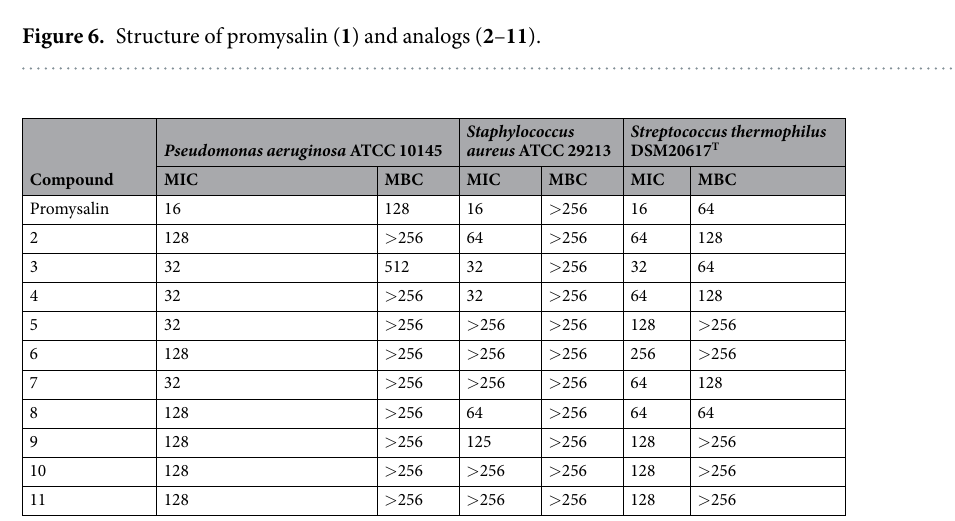
Table 2. Minimal inhibitory concentration (MIC, μ g/ml) and minimal bactericidal concentration (MBC, μ g/ml) values of promysalin and analogues against Gram-negative and Gram-positive